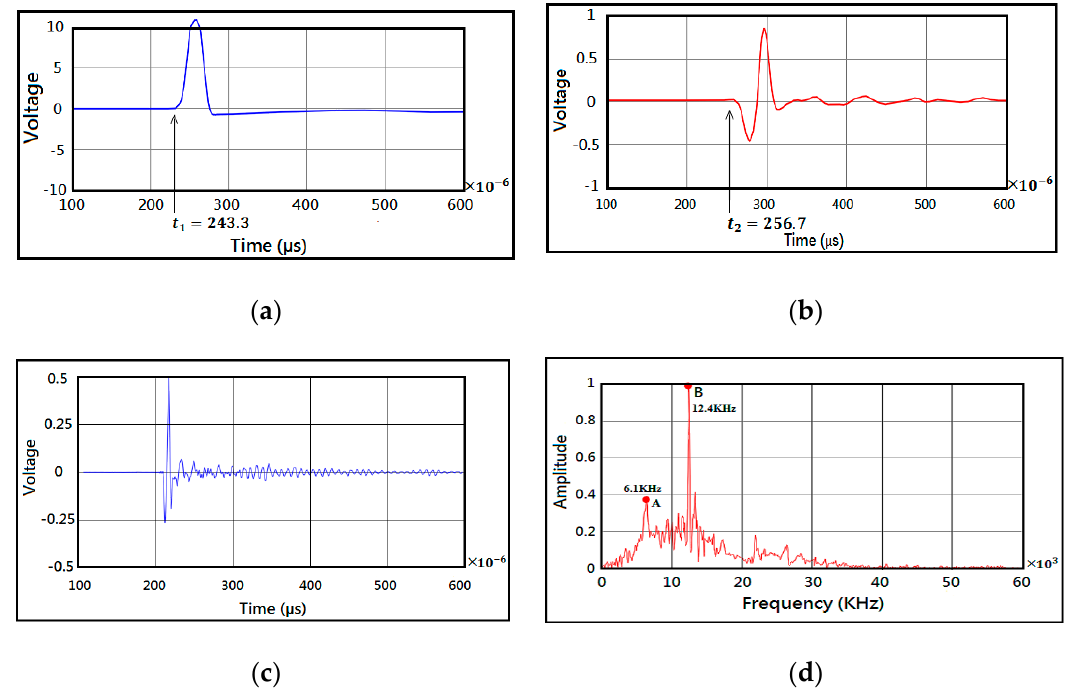
Figure 12. Impact wave graph of object 2 with a crack depth of 15 cm: ( a ) incident impact point wave graph; ( b ) first reflected wave waveform graph; ( c ) MATLAB simulation graph; ( d ) spectrogram.